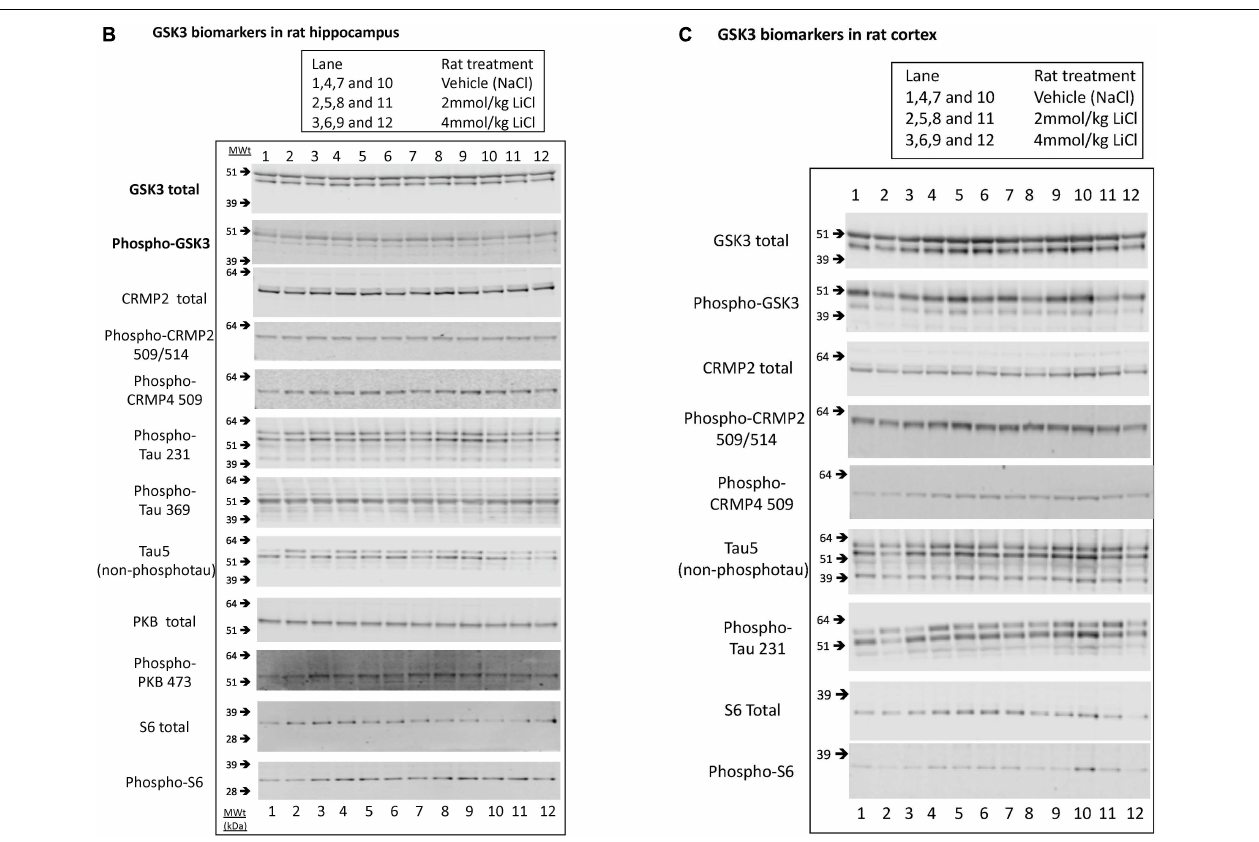
FIGURE 3 | Biomarkers of GSK3 in rat tissues following lithium injection. Rats were given an i.p. injection of vehicle or lithium chloride as detailed in section “Materials and Methods,” and tissues isolated 3 h later. Representative examples of Western blots of rat protein lysates isolated from (A) rat PBMCs, (B) Hippocampus, or (C) Cortex, are provided using the antibodies stated. In (A) , we also provide a comparison of vehicle treated rat PBMC lysate with rat brain cortex lysate with every antibody as evidence for the utility of each antibody (antibody control). The ratio of expression of GSK3 phosphorylation at the N-terminal inhibitory site to the overall isoform expression was quantified from the images as detailed in section “Materials and Methods,” and is provided for each tissue ( ± SD) in the table inserted into A . The red box highlights the major biomarker changes in response to lithium, although only the P-GSK3 β -total GSK3 β ratio was significantly increased by lithium ( p < 0.05, student t test).